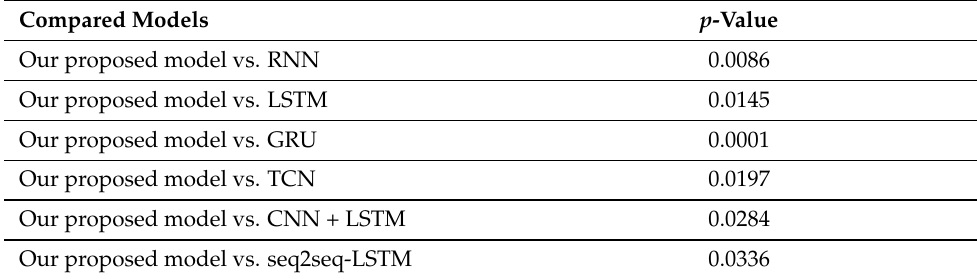
Table 2. Wilcoxon signed-rank test results for one day ahead forecasting results. Compared Models p -Value Our proposed model vs.